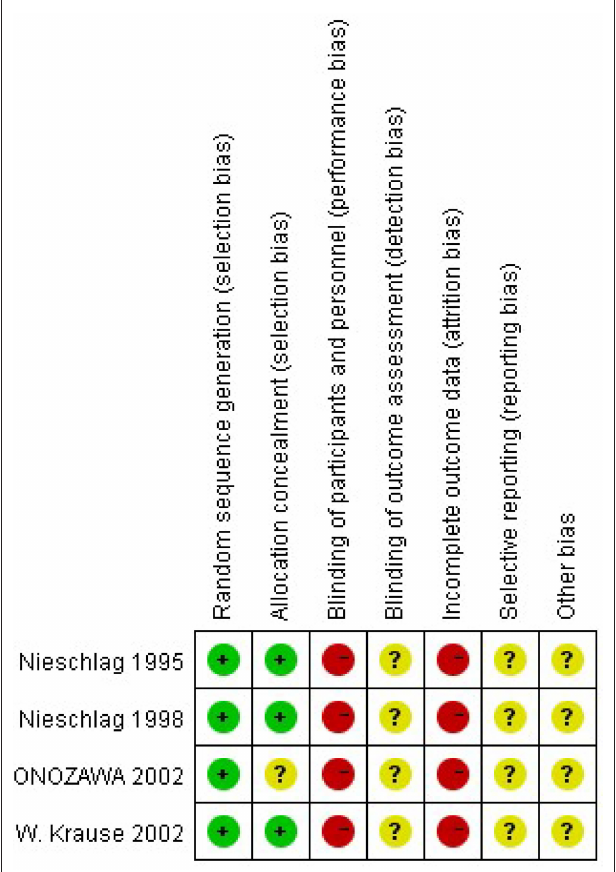
FIGURE 2 | The methodological quality of each study by four-item scale of risk of